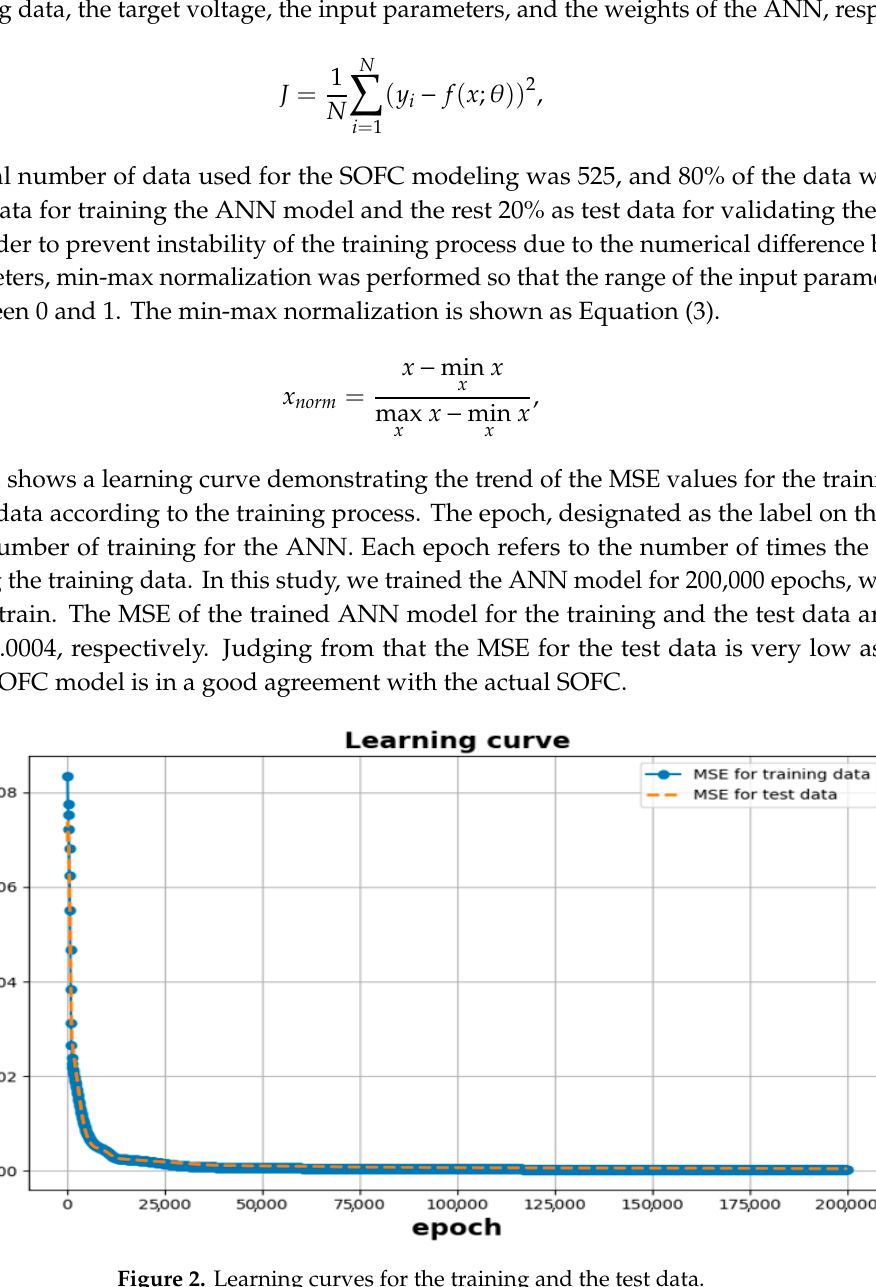
Figure 3. Experimental data points and polarization curves of the SOFC model based on the neural network for: (a) Electrolyte thickness, ranging from 4 to 20 μ m, (b) anode support thickness, ranging from 0.5 to 2.45 mm, (c) anode support porosity, ranging from 32 to 76%, and (d) cathode interlayer thickness, ranging from 6 to 105 μ m. 3. Results and discussion 3.1. Optimization of Design Parameters